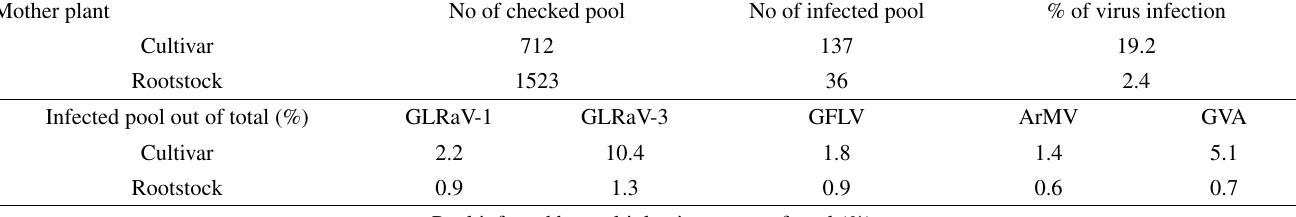
Table 1 - Rates of virus infection for cultivar or rootstock pools detected by ELISA test Mother